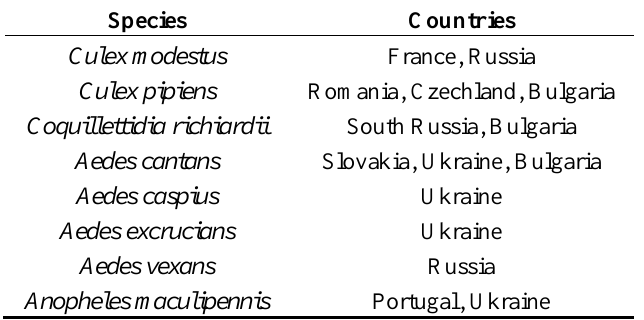
Table 9. Isolations of WNV from mosquitoes in Europe (modified from Hubálek 1999 [52]). Species Countries Culex